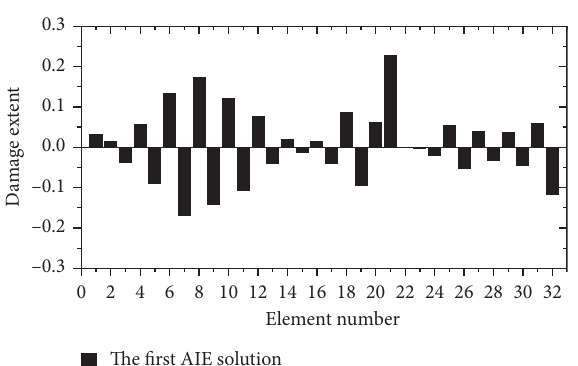
Figure 12: Damage assessment result by the first AIE when element 21 is damaged.